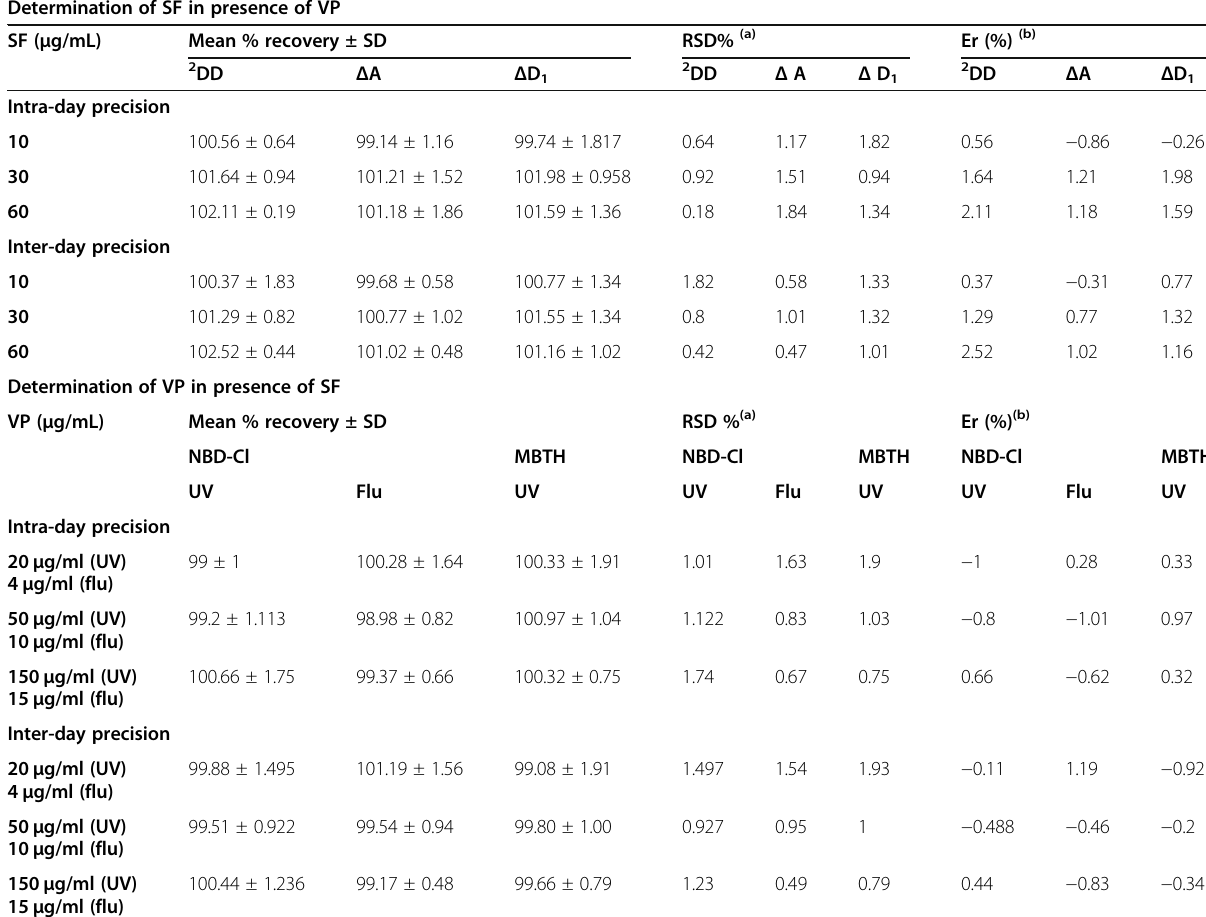
Table 3 Intra-day and inter-day precision of derivative ratio, delta absorbance, first derivative of delta A for the determination of SF in presence of VP and for spectrophotometric (UV) and spectrofluorimetric (flu) determination of VP in presence of SF using NBD-Cl and MBTH